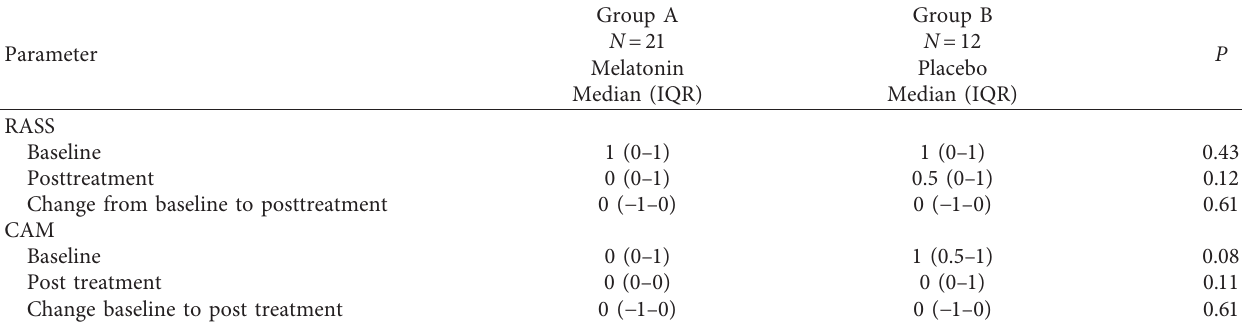
Table 3: CAM and RASS scores distributed per randomized groups.